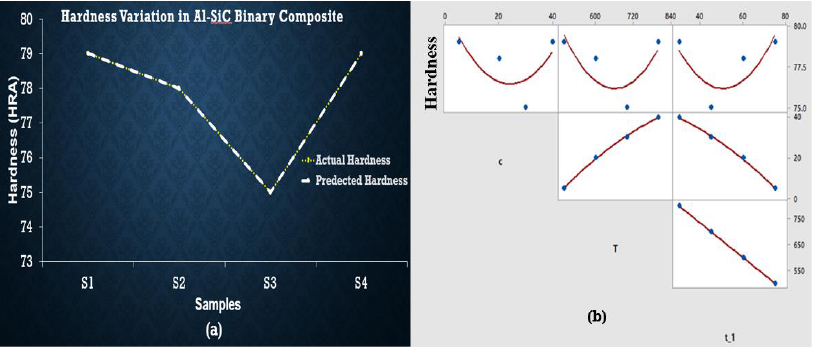
Figure 5. ( a ) Regression plot for Al-SiC showing overlapping of actual and predicted hardness values points (yellow dotted line presents actual value of hardness and white line shows predicted values). ( b ) Matrix plot showing the individual relationship between hardness and input variables for Al-SiC.